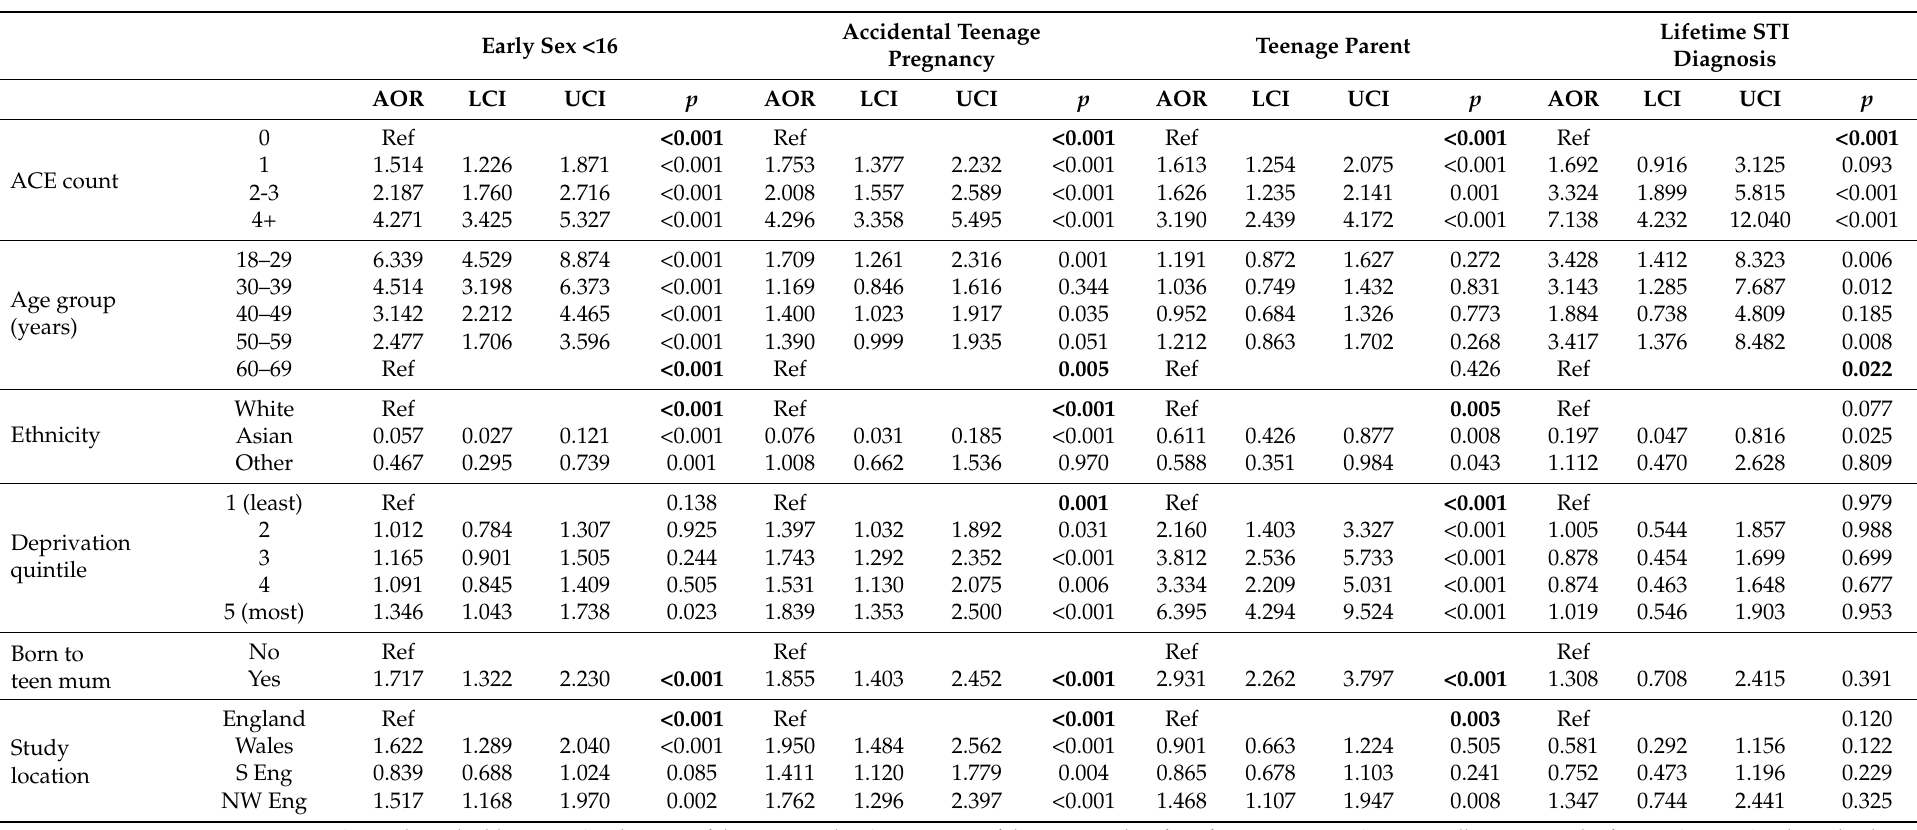
Table 3. Adjusted odds ratios for sexual health outcomes: